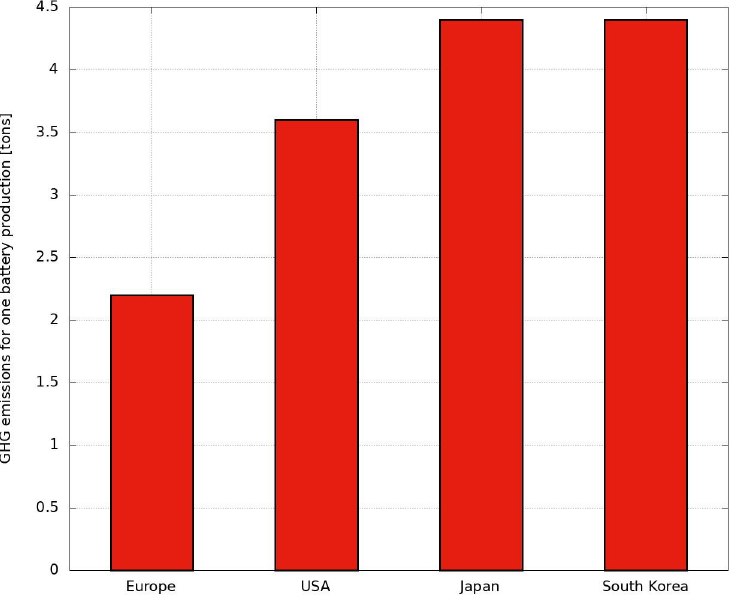
Figure 6. GHG emissions (in tons of CO 2 ) to produce one single battery [10].